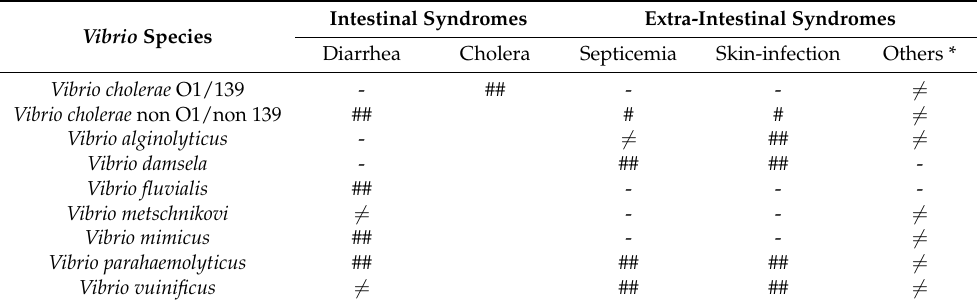
Table 1. Some disease conditions initiated by pathogenic Vibrio